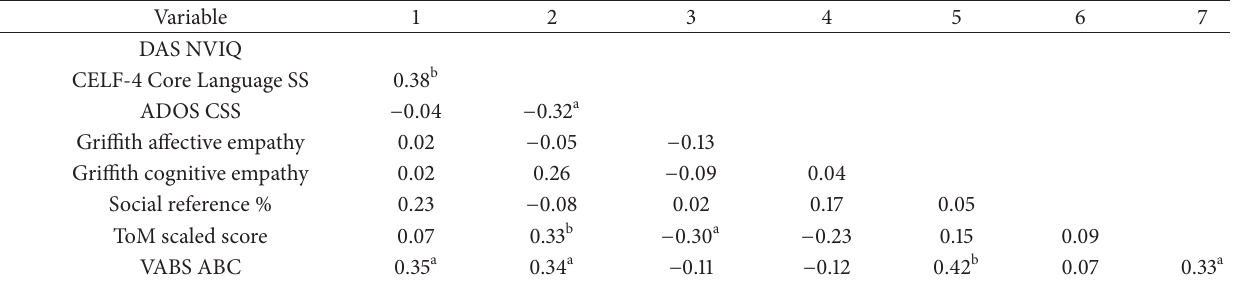
Table 4: Behavioral intercorrelations, excluding ASD